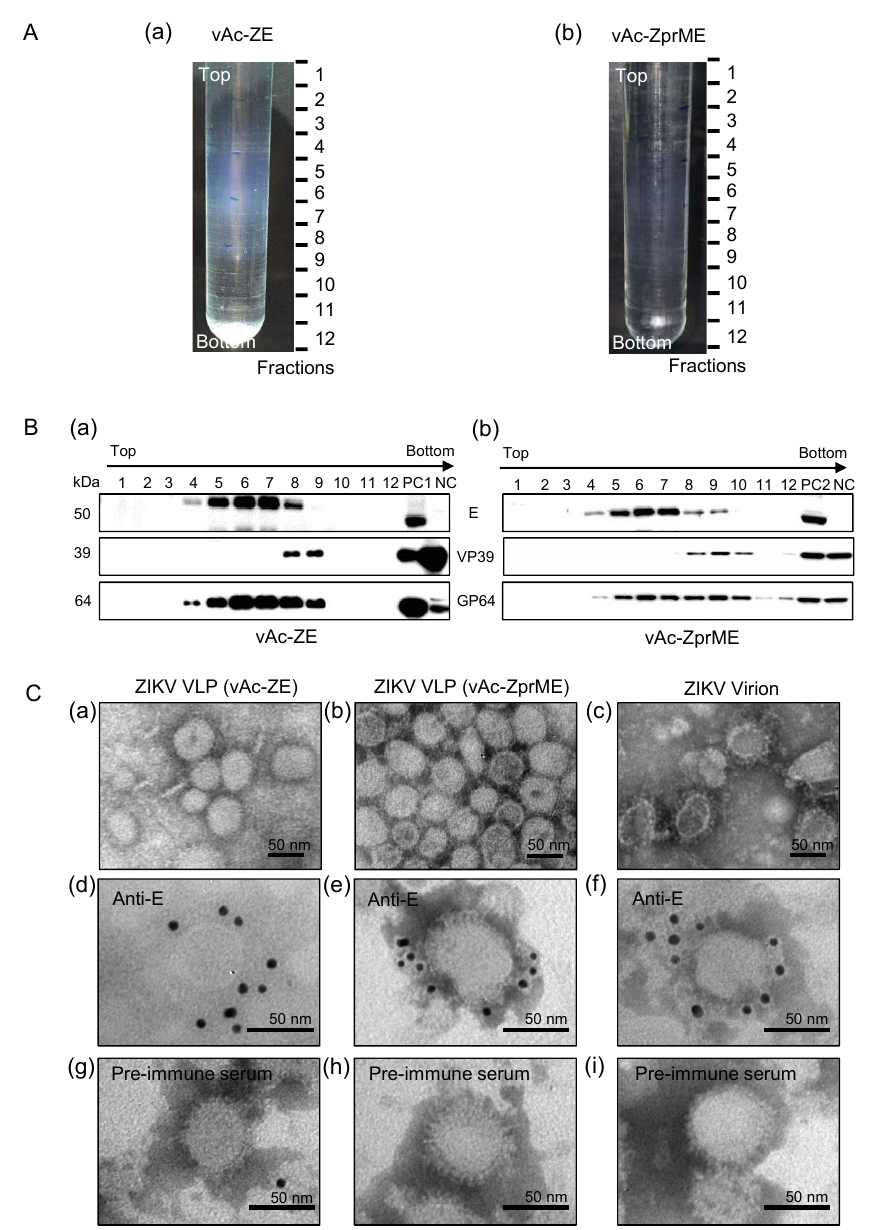
Figure 4. Characterization of baculovirus-expressed ZIKV VLPs from culture supernatants. ( A ) Culture supernatants of vAc-ZE ( a ) and vAc-ZprME ( b ) infected Sf9 cells were concentrated and layered onto 10–60% sucrose gradients and subjected to centrifugation. Twelve fractions were taken from top to bottom. ( B ) Western blot analysis of purified sucrose gradient fractions of culture supernatants of Sf9 cells infected with vAc-ZE ( a ) and vAc-ZprME ( b ) using the indicated antibodies. PC1: positive control 1 (vAc-ZE infected Sf9 cells); PC2: positive control 2 (vAc-ZprME infected Sf9 cells); NC: negative control (vAc-hsp70-egfp infected Sf9 cells). ( C ) Electron micrographs of negative staining and immunogold labeling of VLPs and ZIKV. ( a , b ) Negative staining of purified ZIKV VLPs from the E antigen-enriched fractions from the sucrose gradient fractions of culture supernatants of Sf9 cells infected with vAc-ZE ( a ) and vAc-ZprME ( b ); ( c ) Negative staining of purified ZIKV virions; ( d – f ) IEM of ZIKV VLPs (vAc-ZE) ( d ) ZIKV VLPs (vAc-ZprME) ( e ) and ZIKV virions ( f ) using anti-ZIKV-E-specific polyclonal antibody as primary antibody; ( g – i ) IEM of ZIKV VLPs (vAc-ZE) ( g ), ZIKV VLPs (vAc-ZprME) ( h ) and ZIKV virions ( i ) using rabbit pre-immune serum as primary